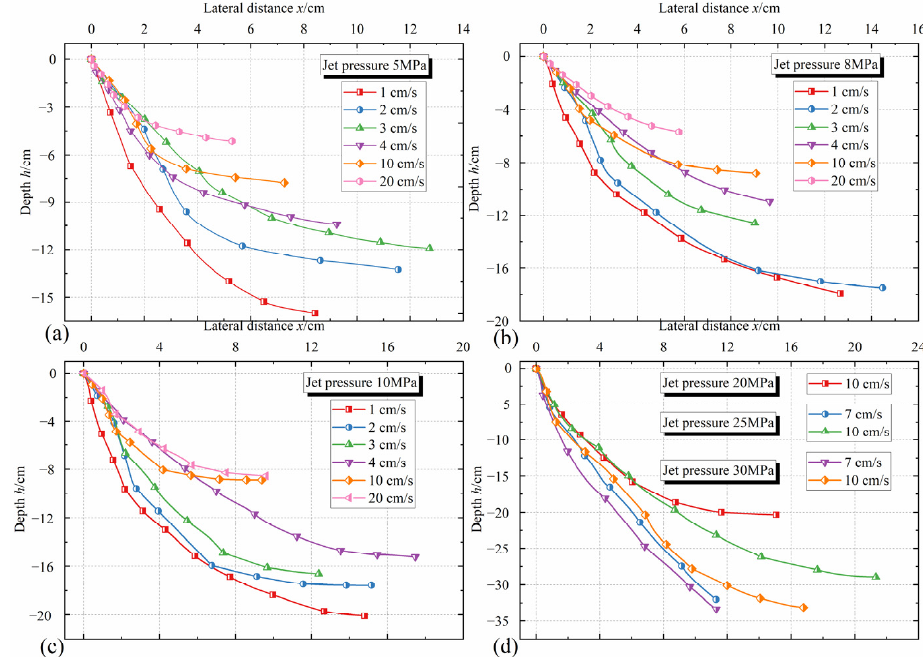
Figure 8. Erosion surface shape curves: ( a ) jet pressure 5 MPa; ( b ) jet pressure 8 MPa; ( c ) jet pressure 10 MPa; ( d ) jet pressure 20, 25 and 30